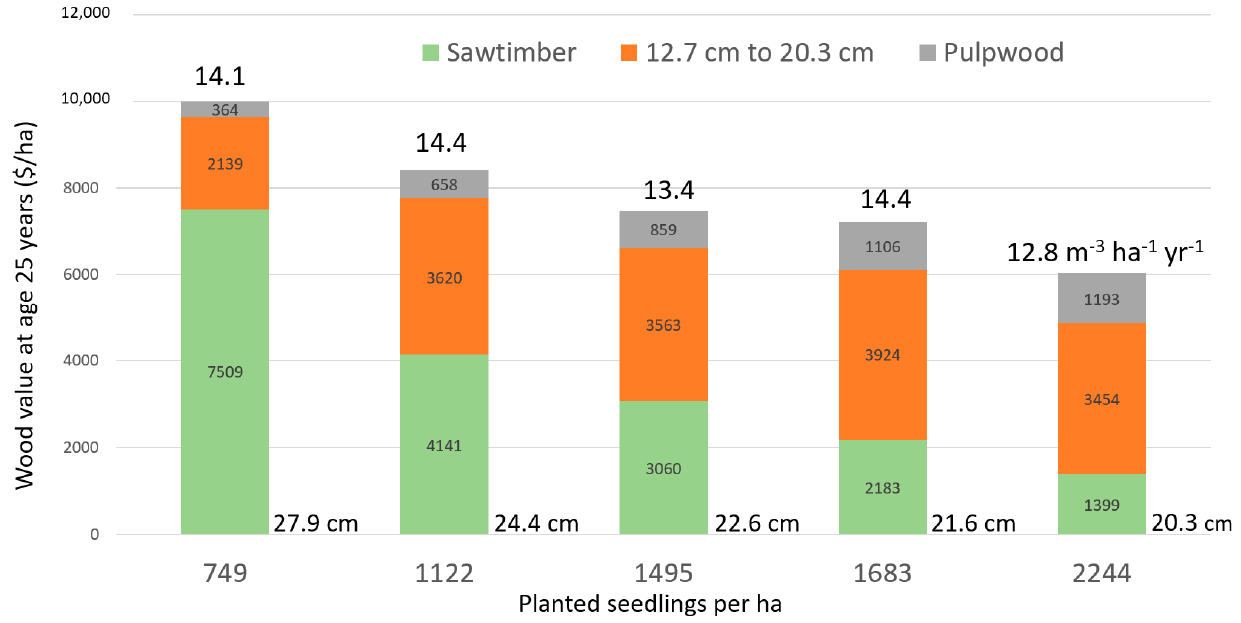
Figure 33. A 25-year old, non-thinned loblolly pine stand (749 planted seedlings ha − 1 ) has 145% more sawlogs than a stand planted with twice as many seedlings. Data from [222]. Too many surviving seedlings can increase wood production while reducing economic returns. In this example, returns per planted seedling varied from $13.30 to $2.70 ($11 m − 3 for pulpwood and $35 m − 3 for sawtimber). The mean annual increment is listed at the top of each bar, and the average DBH is listed at the right of each bar. Half of the seedlings planted at 2244 ha − 1 died before harvest, while mortality was 22% when seedlings were planted at 749 ha − 1 .